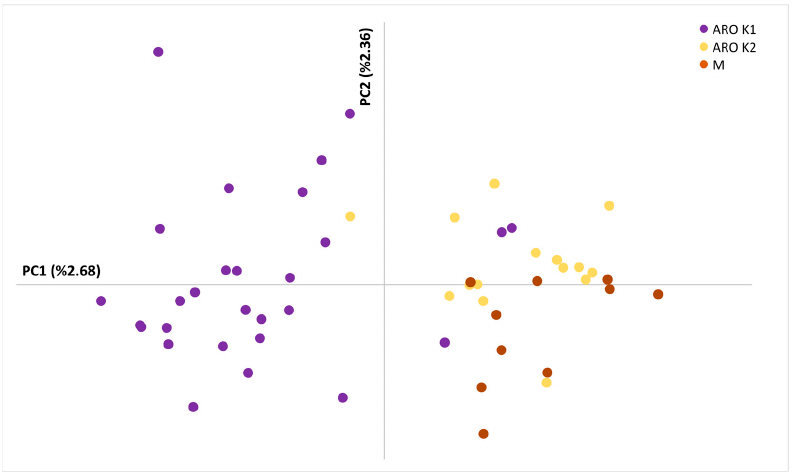
Figure 3. Scatter plot for genetic variation explained by the first two principal components (PCs). Individuals belonging to the ARO_K1, ARO_K2 and M populations are marked with different col-